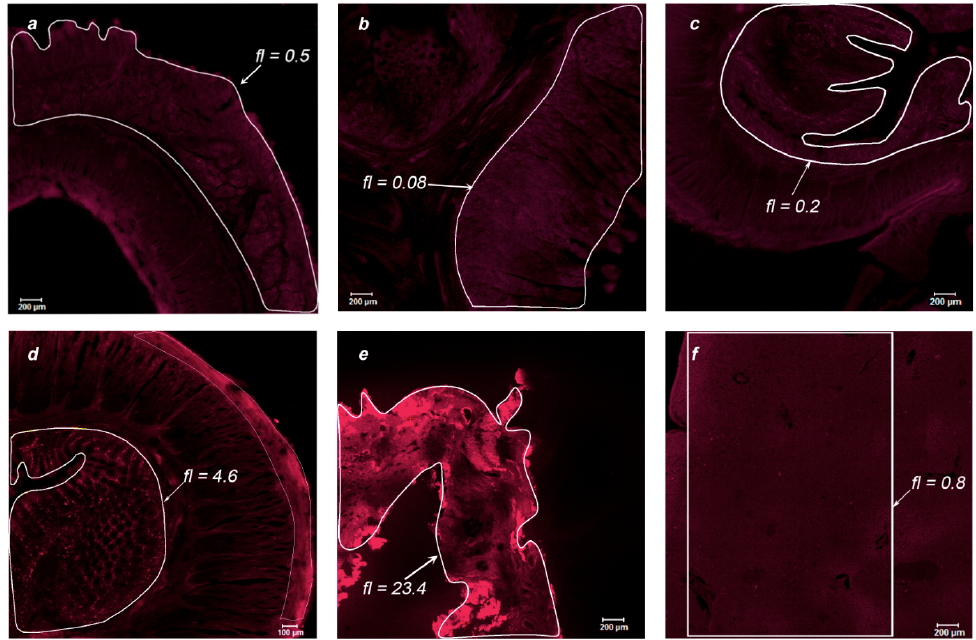
Figure 10. Images of organs of Primate B (24 h after MB administration) obtained using laser scanning confocal microscopy: ( a ) jejunum; ( b ) stomach; ( c ) intestinum crassum; ( d ) colon; ( e ) gallbladder; ( f ) liver. Areas of interest are highlighted in white, according to the accumulated MB. The index corresponds to the level of MB in this area of